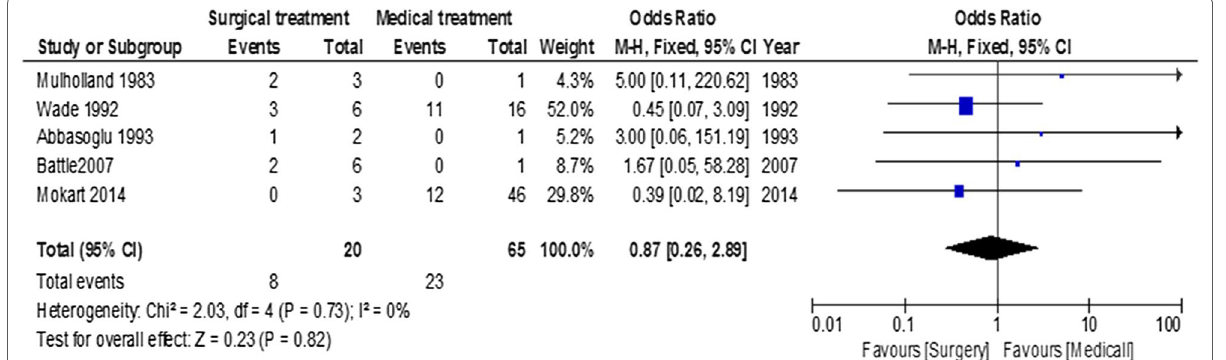
Fig. 6 Summary of odds ratio in included studies according to the presence of neutropenia the day of